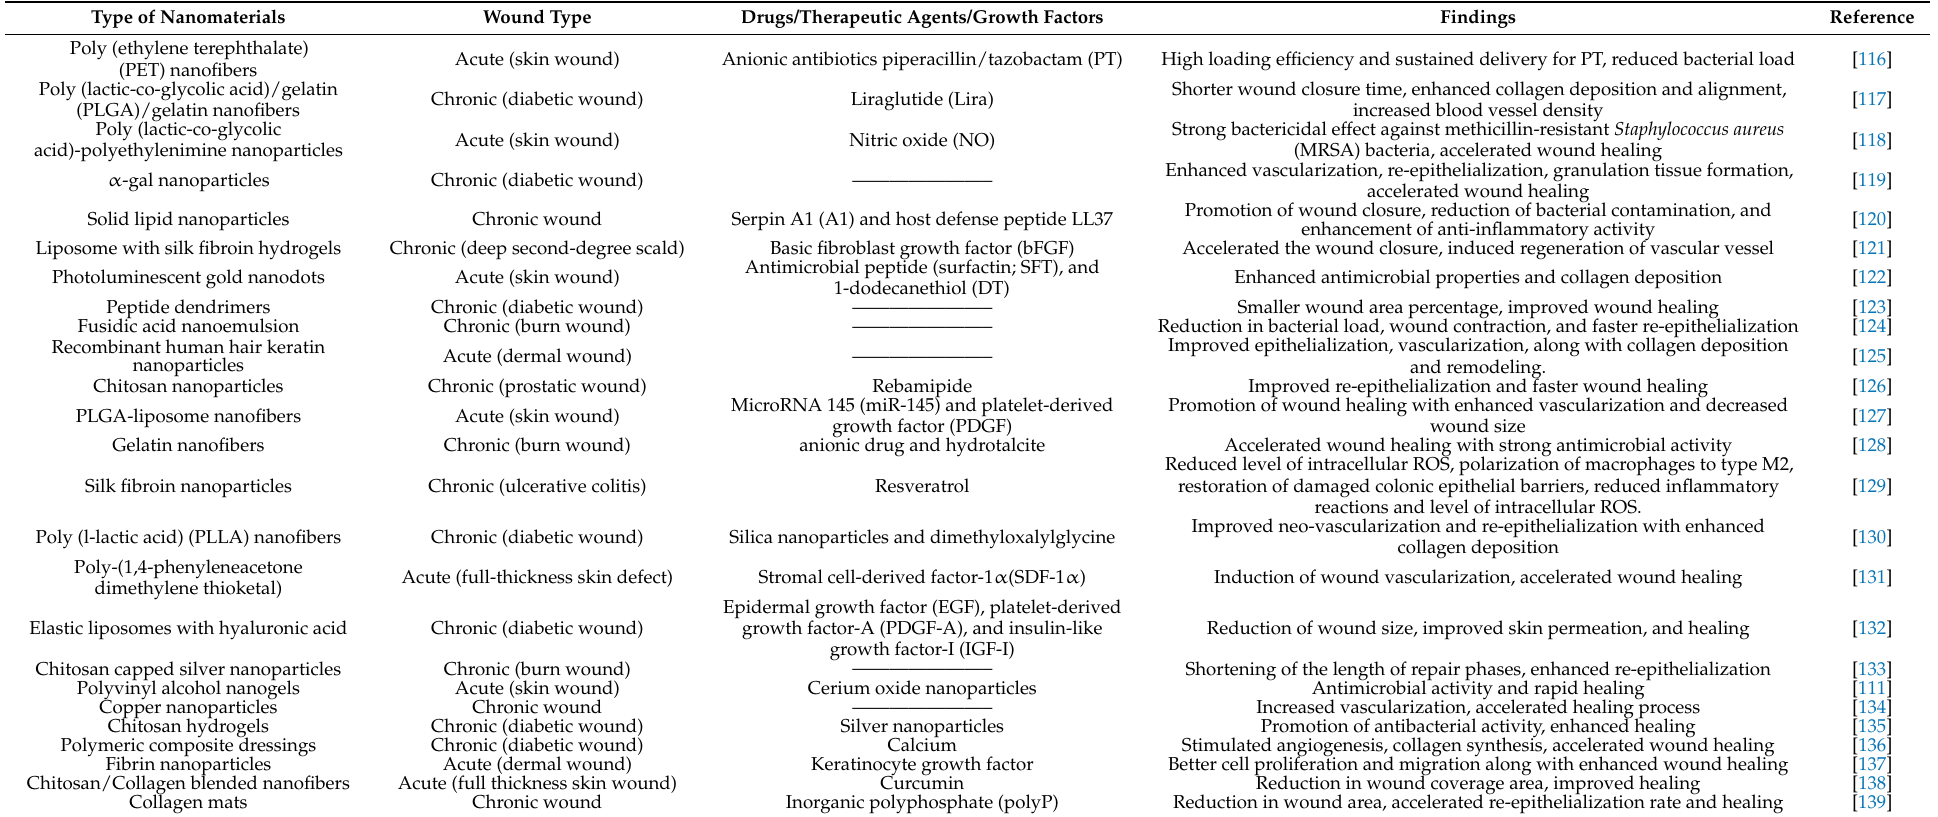
Table 1. A list of recent nanotherapeutic approaches for wound healing applications along with wound type being treated, loaded drugs/growth factors, and